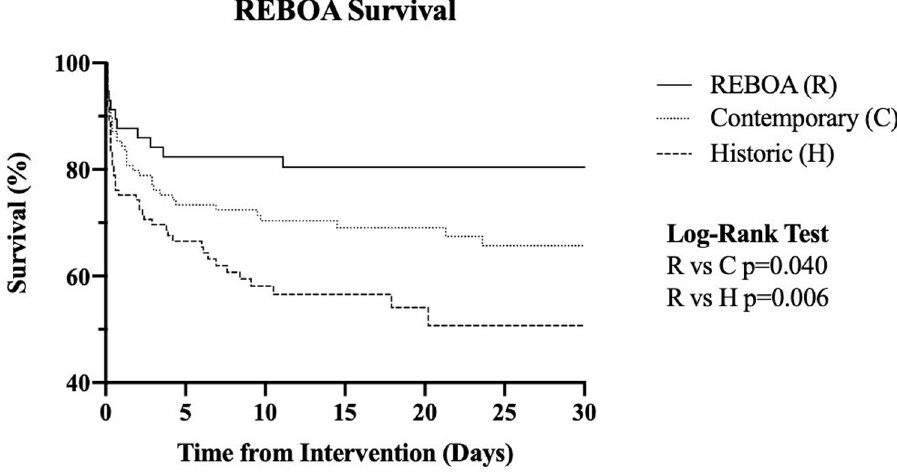
Fig 1. Kaplan-Meier estimates of survival over time to 30 days by group (REBOA, contemporary and historic).